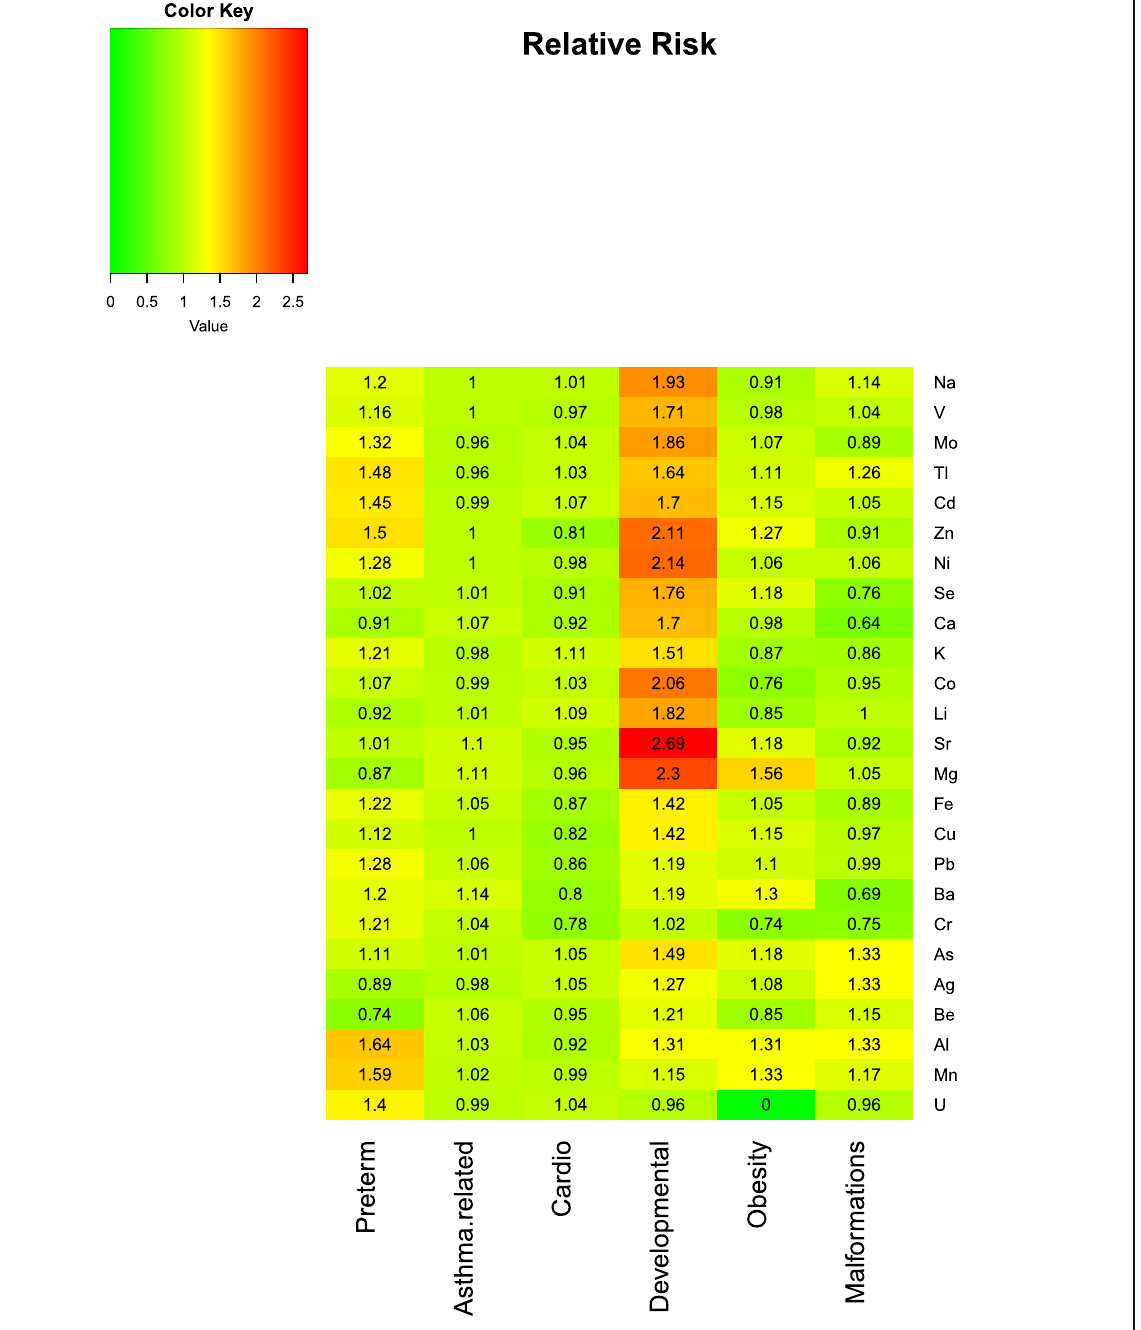
Fig. 1 Heatmap of association between internal dose of metals in quintiles and presence of a clinical outcome at birth, adjusted to maternal and newborn clinical background and expressed as relative risk (the color scale ranges from green assigned to protective factors to red assigned to risk factors with relative risk >